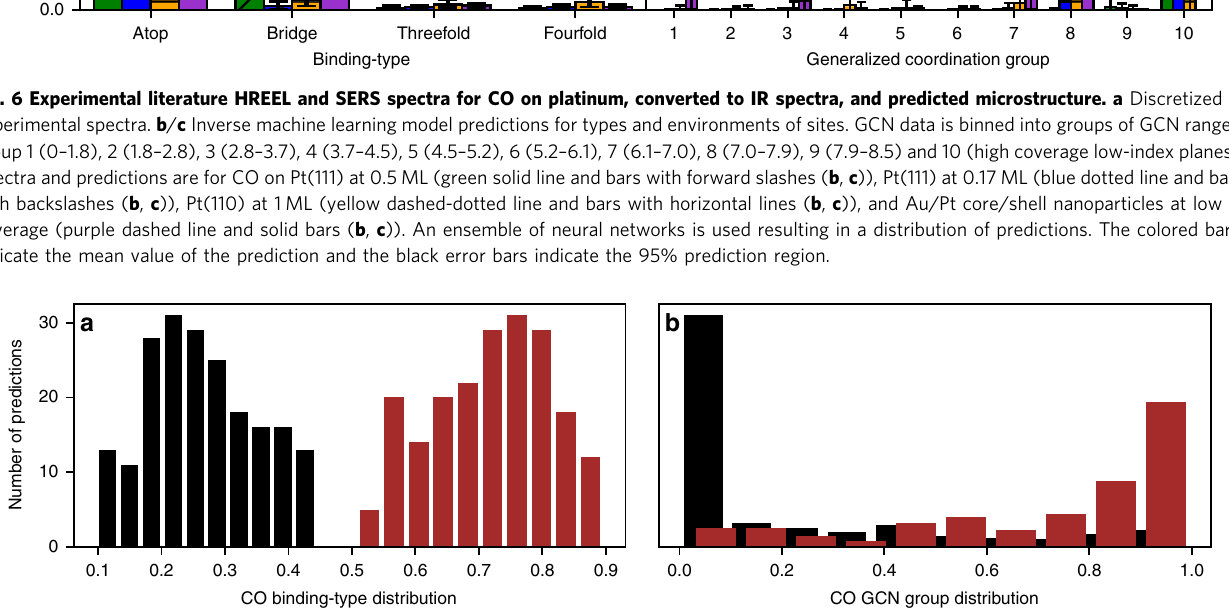
Section 2: DFT calculations . Forces used for Hamiltonians and electron densities for dipole moments were obtained using the Vienna ab initio Simulation Package